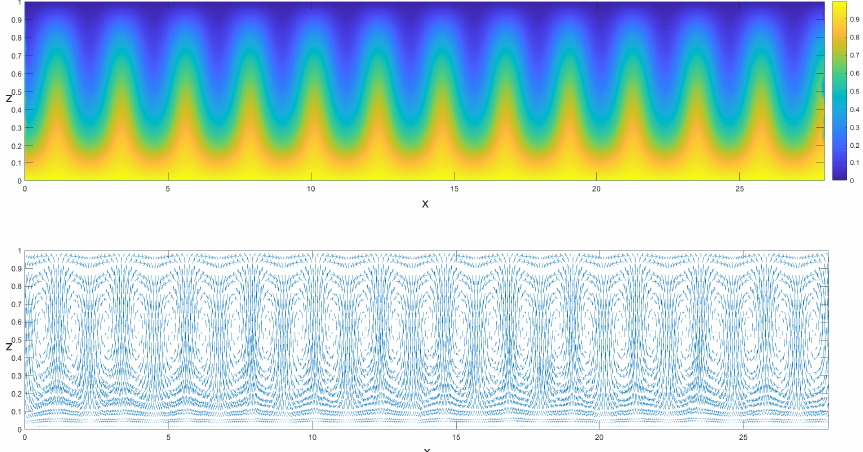
Figure 5. Isotherms and velocity field of the numerical solution obtained with finite elements; R = 1300 and Γ =